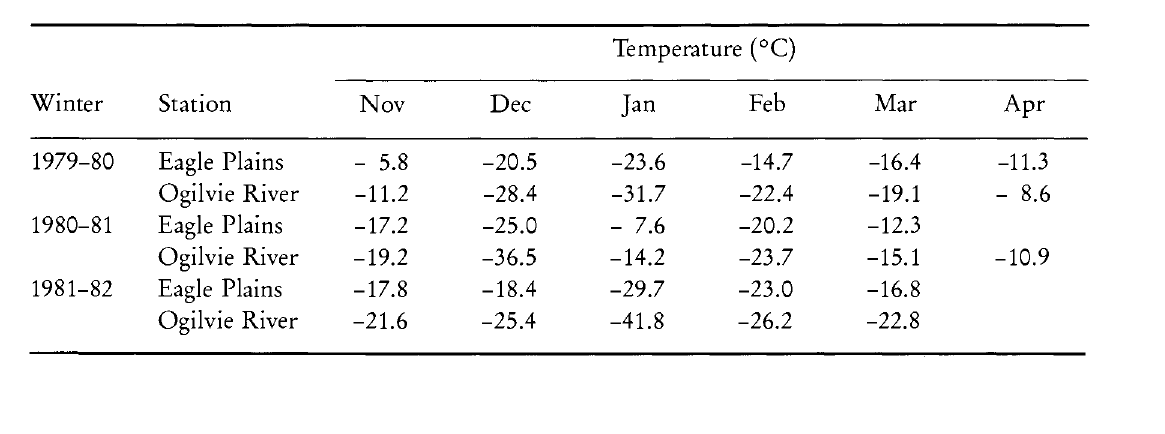
Table 2.1. Mean daily temperatures at two locations on the Dempster Highway,